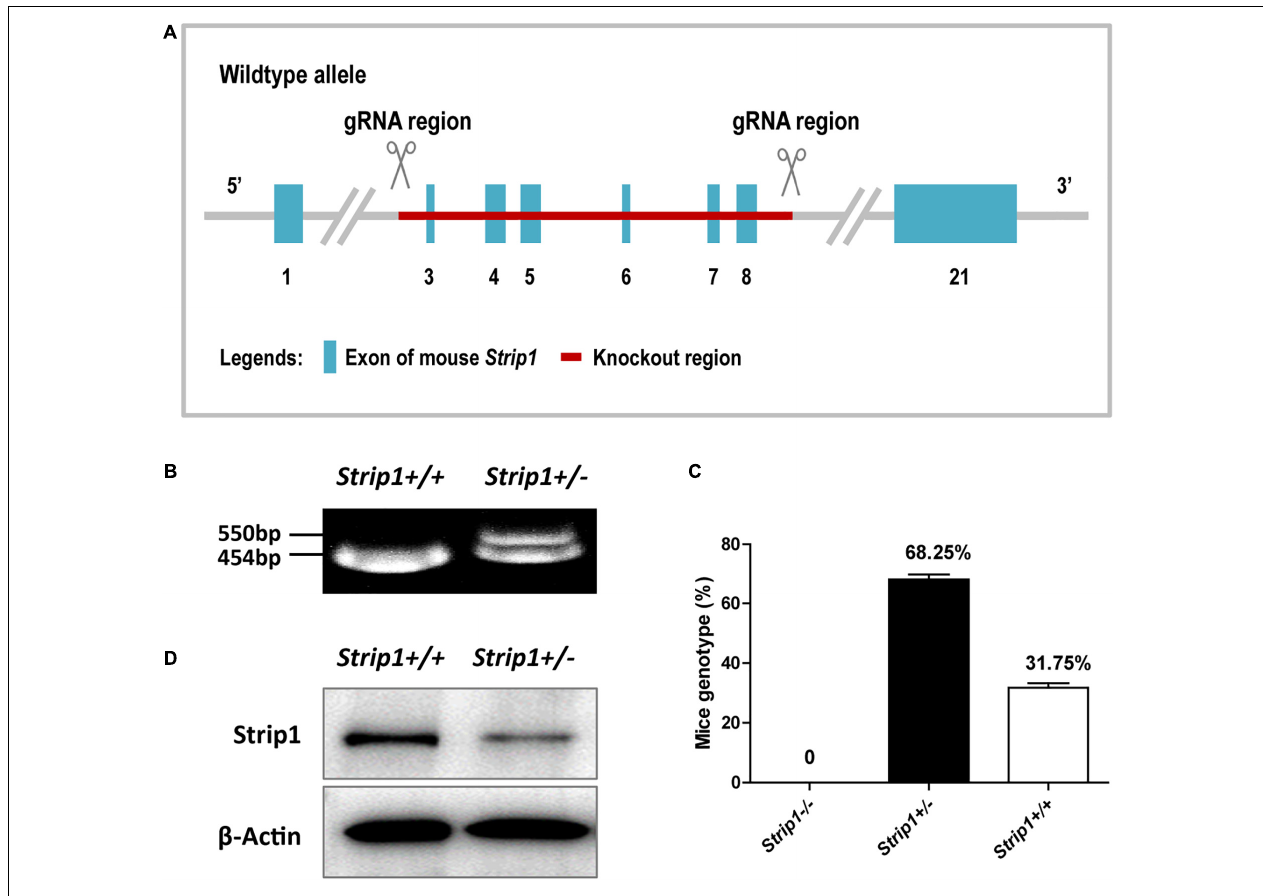
FIGURE 3 | The construction and breeding of the Strip + / − mice. (A) Exons 3–8 of Strip1 were deleted to knock out the Strip1 gene. (B) Genotyping of Strip + / − mice and their offspring. The mutant allele is 550 bp, and the wild type allele is 454 bp. (C) The ratio of mice with different genotypes. There were no Strip1 –/– mice, while the percentages of Strip + / − mice and Strip1 +/+ mice were 68.25 and 32.75% per litter, respectively. Three litters of mice were counted. (D) Western blotting showing Strip1 protein expression level in Strip1 +/+ and Strip + / − mice. β -actin was used as the endogenous reference